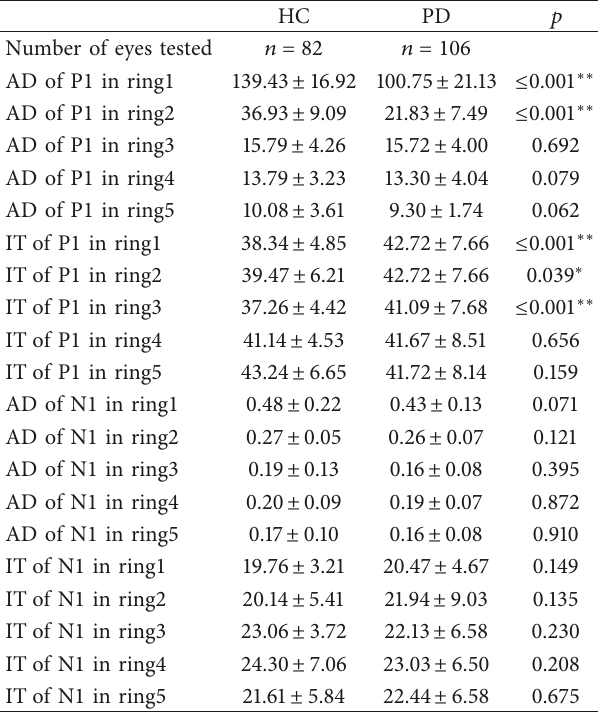
Table 2: Retinal function analysis of PD patients and healthy subjects using